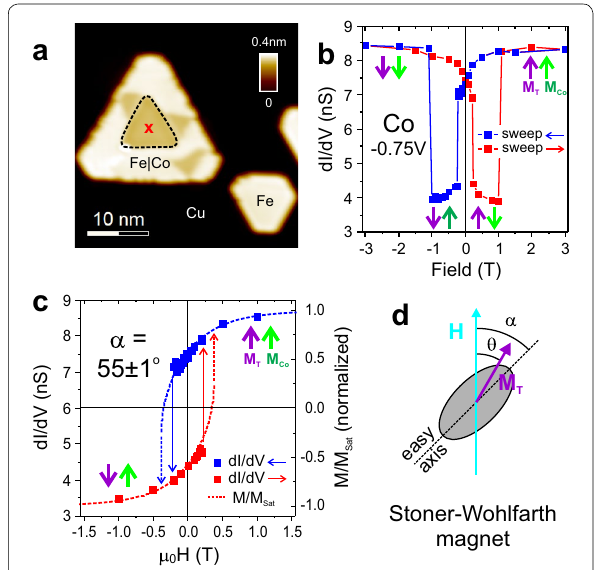
Fig. 7 Stoner‑Wohlfarth response of spin‑STM tip. a A STM image showing a Fe|Co island and Fe island ( V b 0.3 V, I set 3 nA). The = − = black dashed curve encloses the Co core. b and c Magnetic hysteresis loops of d I /d V signals ( V b 0.75 V) of the STS spectra measured at = − the center (marked by the cross ) of the Co core of the island A (field sweep between 3 T and 3 T for b ; field sweep between 1 T and − + − 1 T for c ). Red ( blue ) color code denotes the d I /d V values meas‑ + ured for the forward ( backward ) field sweep. The purple and green arrows indicate the directions of the magnetizations of the tip and Co core, respectively. Note that the Co magnetization M Co retains its orientation in c . The dashed curves in c are fits according to the SW model of the data with as a fit parameter. The solid ( dashed ) red arrows indicate the magnetization switching of the tip (the SW‑magnet). d Description of the tip magnetization vector M T based on a SW model. α and θ represent the polar angles of the magnetic easy axis and the magnetization vector, respectively, with respect to the direction of the external magnetic field (along the z ‑axis) (Reprinted from [7] with permission from Nature Publishing Group (Copyright